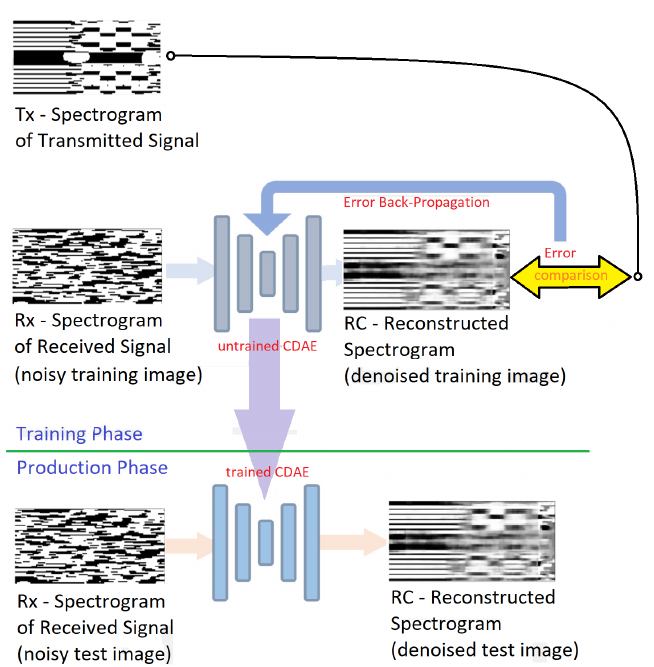
Figure 4. Schematic view of the operation for signal denoising using a Convolutional Denoising Autoencoder (CDAE). The input is noisy data (spectrograms of the received signal under various channel propagation scenarios). The encoder and decoder consist of multiple convolutional layers: the output is compared to the clean signal’s spectrogram. By optimizing the loss function, the network finds a denoised representation